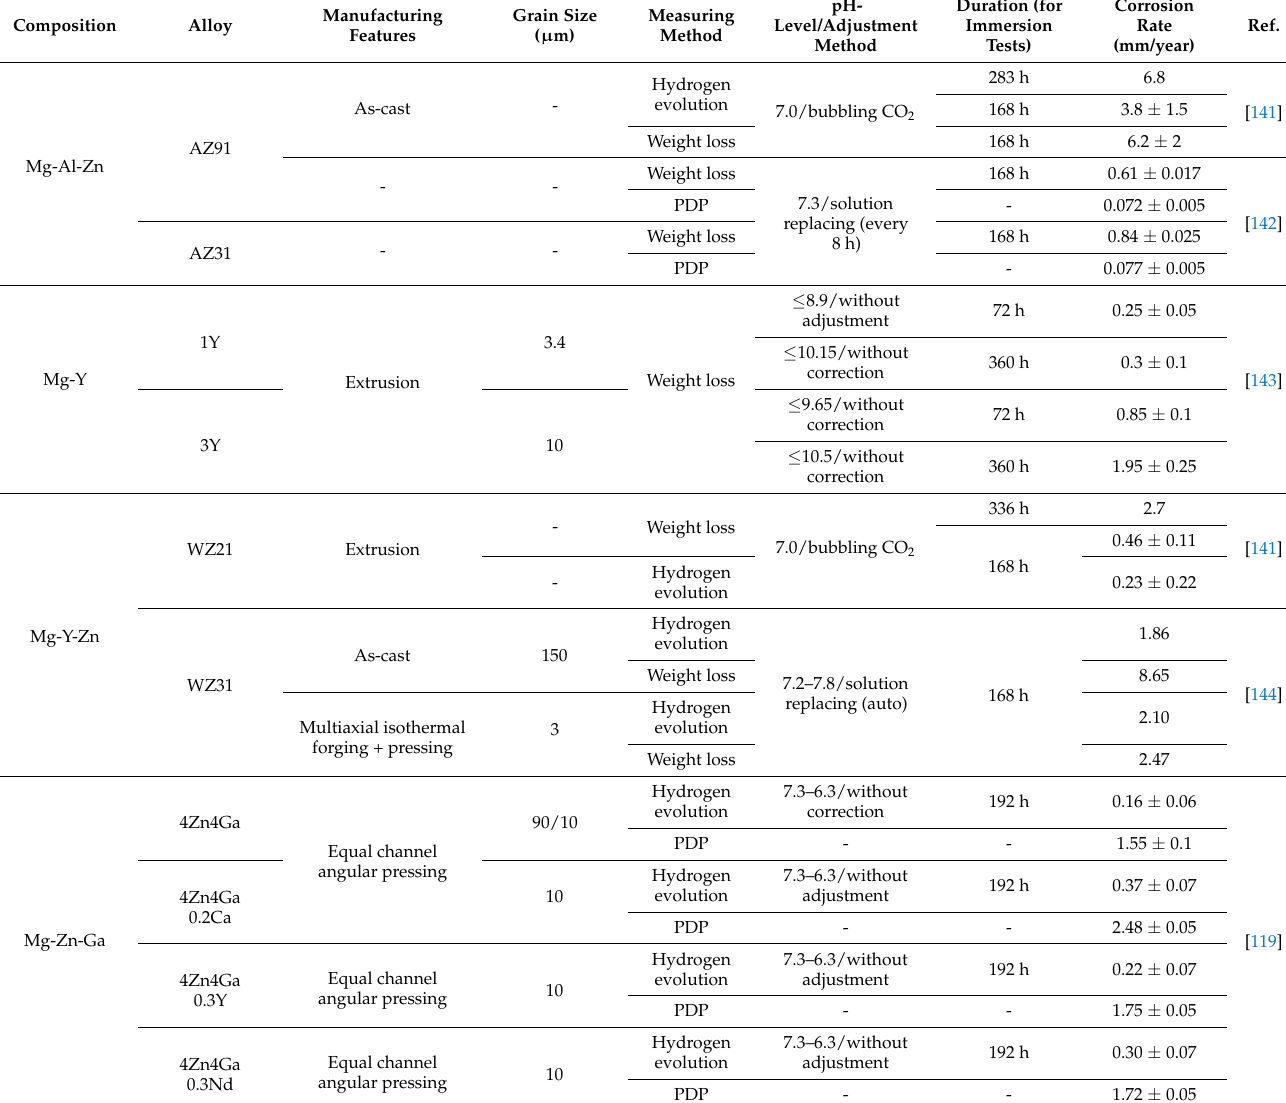
Table 3. Corrosion rate of biodegradable Mg-based alloys in Hanks’ solution at 37 ◦